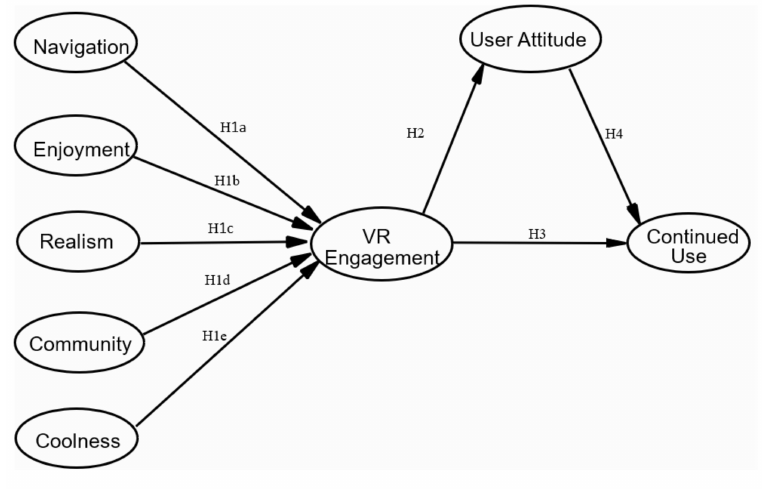
Figure 1. The conceptual